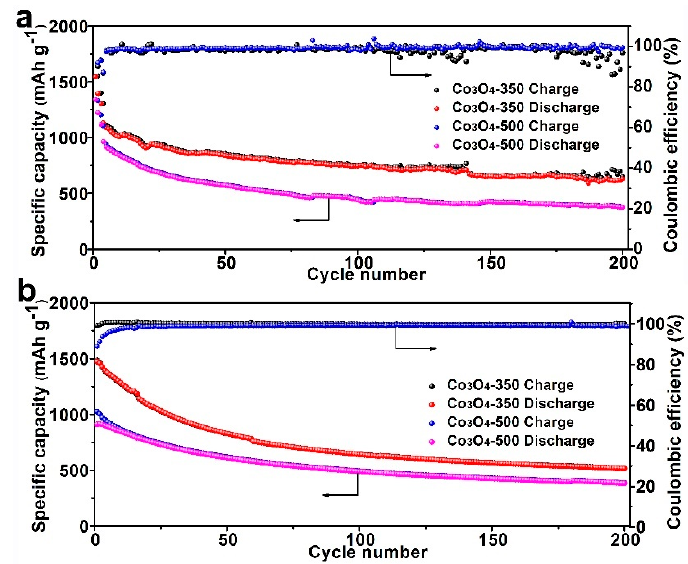
Figure 6. The cycling performances of Li–S cells using varied separator at room temperature ( a ) and 80 °C ( b ).